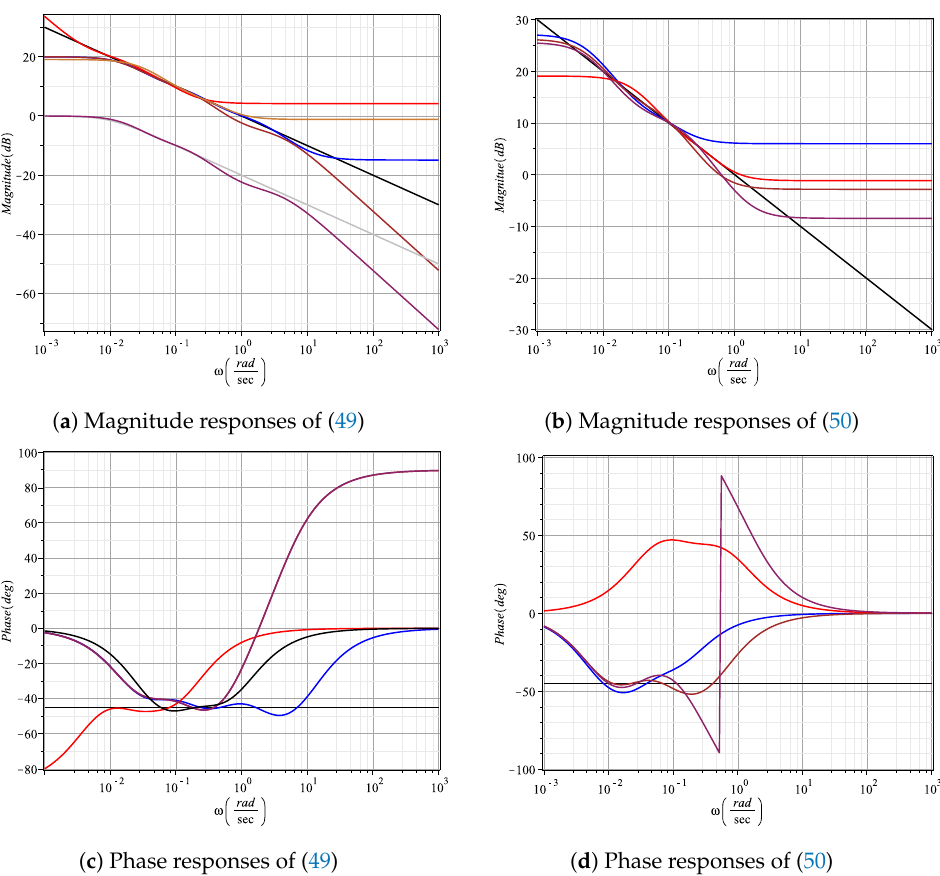
Figure 4. Magnitude and phase responses of reduced order transfer functions by applying Pade’s approximation. ( a ) Ideal behavior (black line) of 1 (red line), Charef’s V1 (brown line), ideal behavior (gray line) of 1 Carlson’s (gold line), ( b ) ideal behavior (black line) of 1 expansion (red line), curve fitting (brown line) and MSBL (maroon line), ( c ) phase responses of ( a , d ), phase responses of ( b